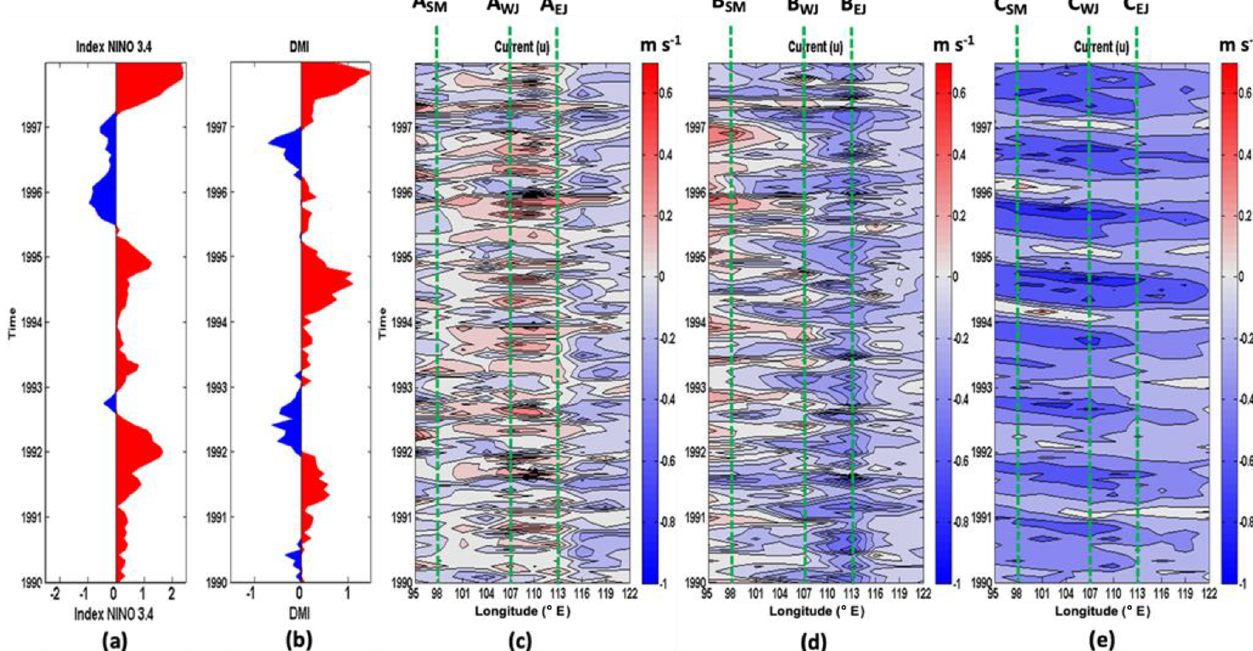
Figure 3. Time–longitude profiles of (a) ONI and (b) DMI and monthly averages of surface (1m) zonal currents along (c) Transect A, (d) Transect B, and (e) Transect C. Positive (negative) values of the zonal currents indicate eastward (westward) currents. Meanwhile, dashed green lines denote the longitudes of the nine selected